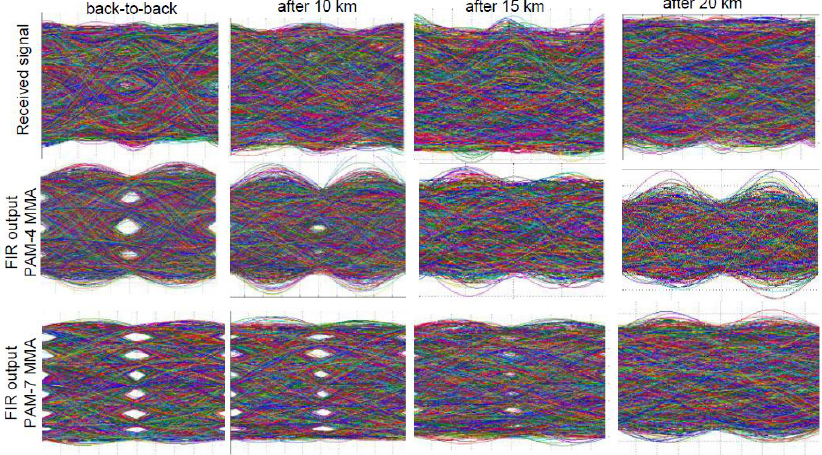
Figure 2. Eye-diagrams before and after finite impulse response (FIR) for back-to-back, 10-km, 15-km, and 20-km for Figure 1b.